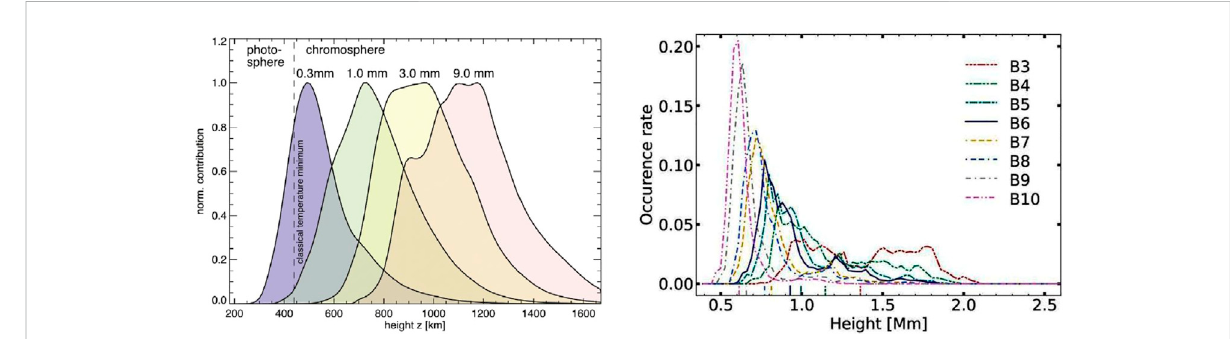
FIGURE 2 Contribution functions for mm- λ . (Left) Contribution functions at four wavelengths between 0.3 and 9.0 mm at the center of the solar disk according to Wedemeyer et al. (2016). Reprinted by permission from: Springer Nature, Space Science Reviews, ⓒ 2019. (Right) QS contribution functions for the ALMA frequency bands according to Eklund et al. (2021). Reproduced with permission ⓒ